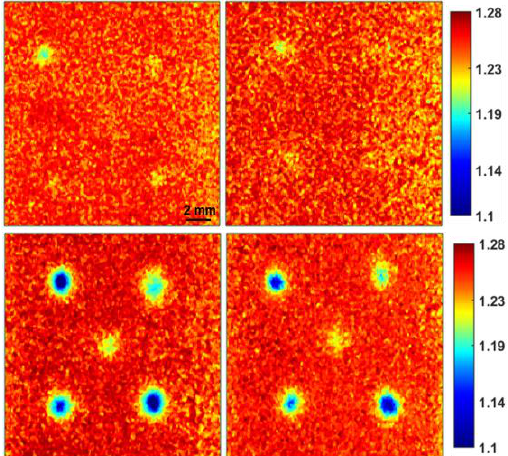
Figure 7. Mapping of hidden small polystyrene pieces using a reflection mirror: Raman spectra of polystyrene ( a ), and principle component analysis (PCA) loading plots calculated for S4 (with mirror) replications 1 ( b ) and 2 ( c ), and the corresponding PCA images on the right side. Note that the PCA results did not show any evidence of polystyrene pieces under wheat flour for the S4 data collected without the mirror.